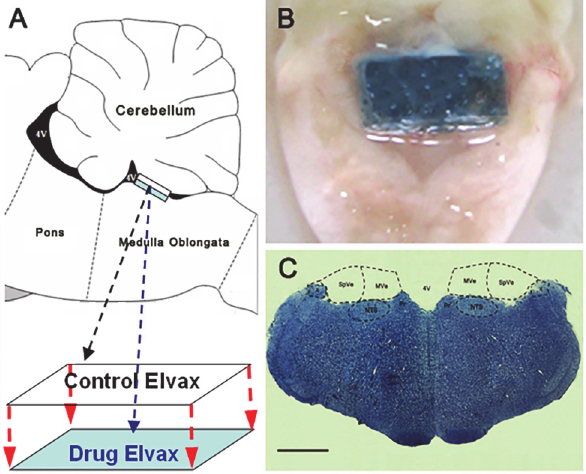
Fig 2. Elvax preparation and CVN tissue sampling. (A) Illustration for Elvax sheet preparation and (B) photograph of a rat brain stem showing the location of Elvax sheet implantation. (C) Representative Nissl- staining image showing the CVN sampling region. 4V: fourth ventricle; MVe: medial vestibular nucleus; SpVe: spinal vestibular nucleus; NTS: nucleus of solitary tract; Pr: prepositus nucleus; X: nucleus X; Bar: 200 μ